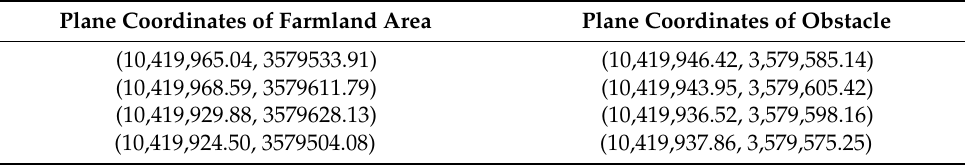
Table 3. Plane coordinates of Figure 9a.